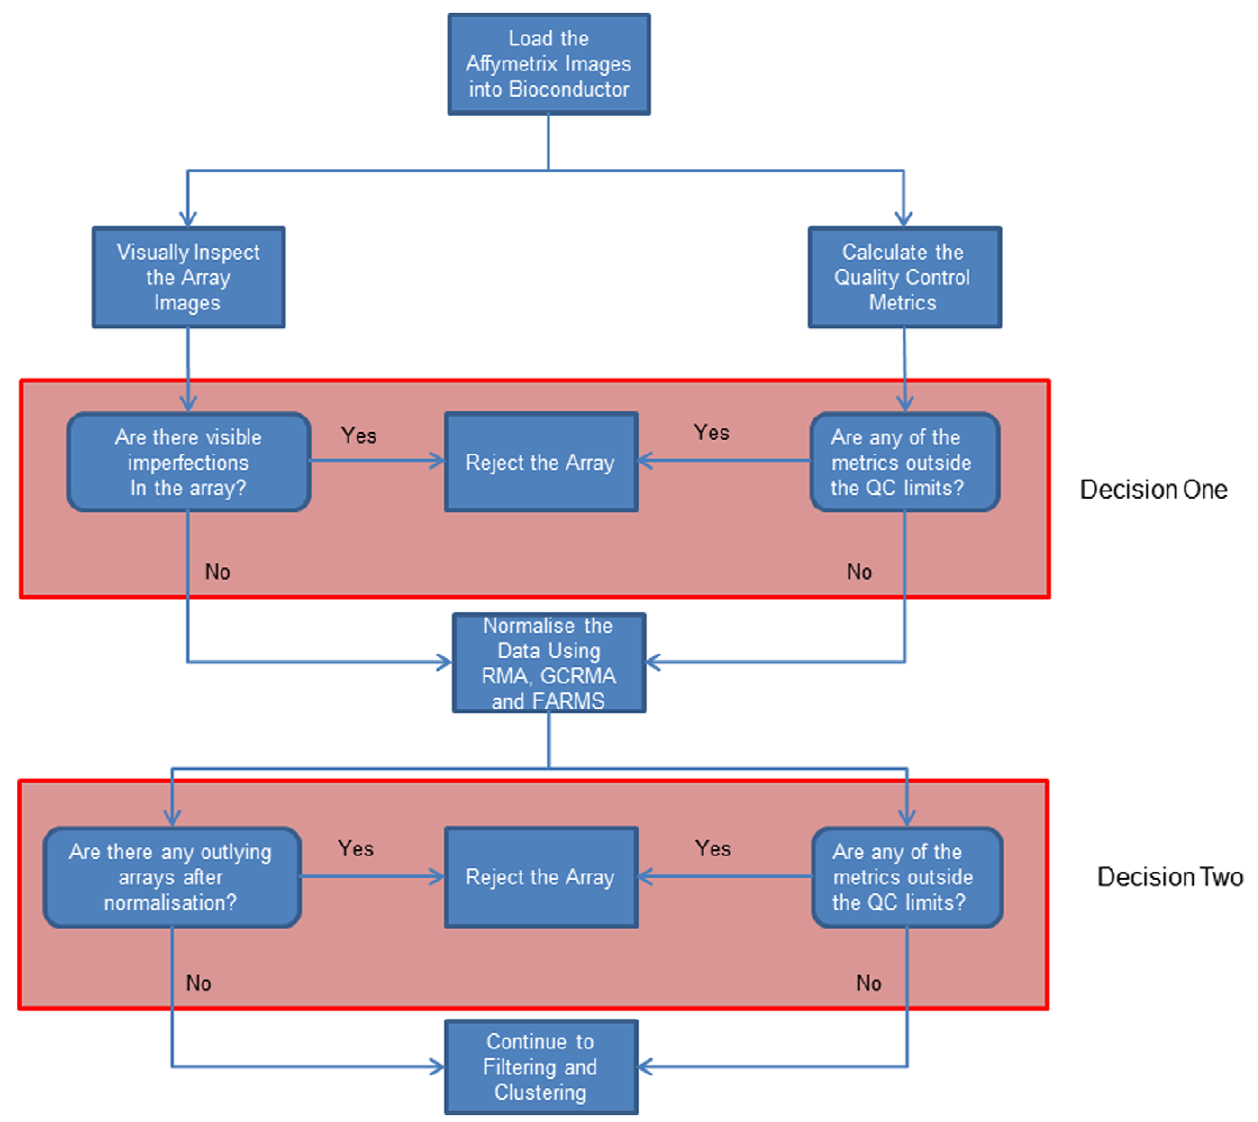
Figure 4. A flowchart summarising the quality control and normalisation steps of the data analysis. The pink boxes indicate when decisions are made to exclude arrays from the analysis because of quality control issues.